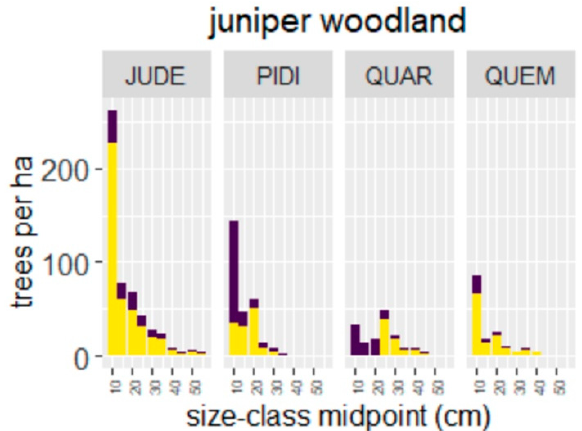
Figure 5. Mean size class distributions (# ha − 1 ) in 5-cm size classes for the pre-fire (yellow) and post-fire (purple) samples for dominant tree species in the three major vegetation types in Chiri- cahua National Monument, Arizona. All tree species experienced significant declines in tree spe- cies abundances in size classes < 20 cm diameter at breast height. Full t-test model results are shown in Appendix